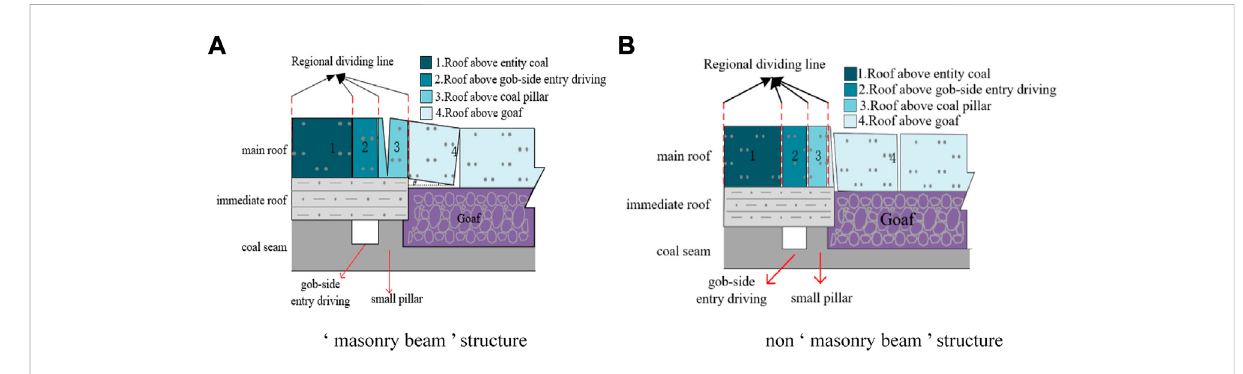
FIGURE 5 (A) Masonry beam structure and (B) non-masonry beam structure.